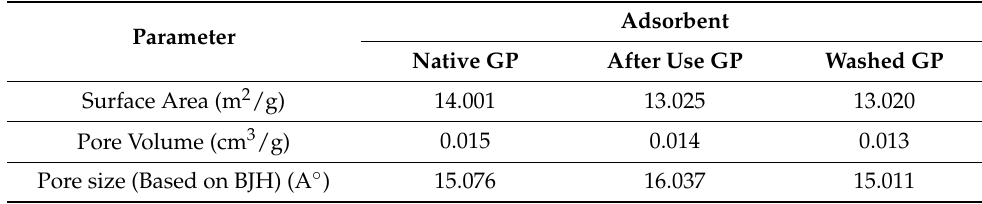
Figure 2. SEM images of before use (BU, A ), after use (AU, B ) and washed garlic peel (W, C ). Table 1. Surface area analysis of native and washed GP.